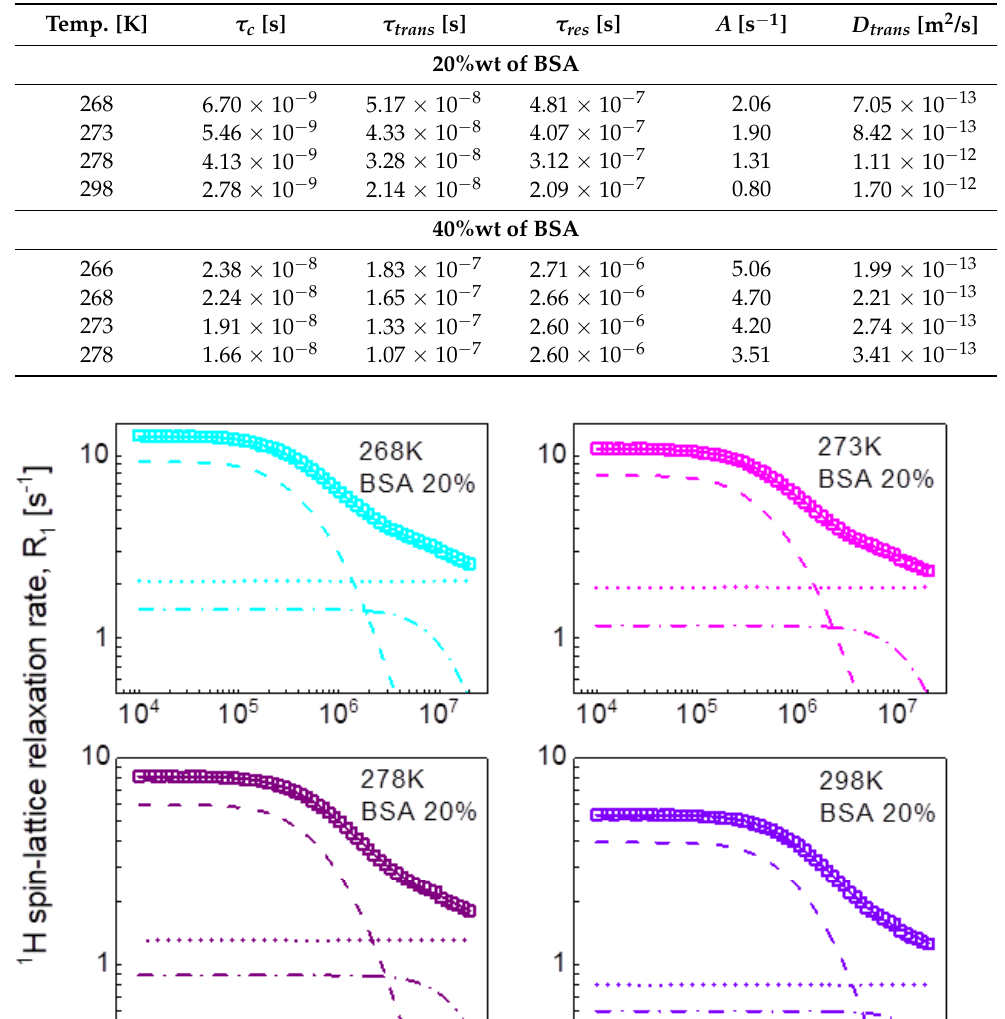
Table 4. Parameters obtained from the analysis of the 1 H spin-lattice relaxation data for BSA–water mixtures in terms of Equation (8). The dipolar relaxation constant, C DD , for 20% and 40%wt concen- tration of BSA yield: C DD = 4.31 × 10 7 Hz 2 and C DD = 9.03 × 10 7 Hz 2, , respectively, the relaxation constant associated with two-dimensional translation diffusion is C trans = 8.04 × 10 6 Hz 2 for 20% of BSA and C trans = 1.07 × 10 7 Hz 2 for 40% of BSA. The translation diffusion coefficient has been obtained from the relationship: D trans = d 2 . 2 τ trans